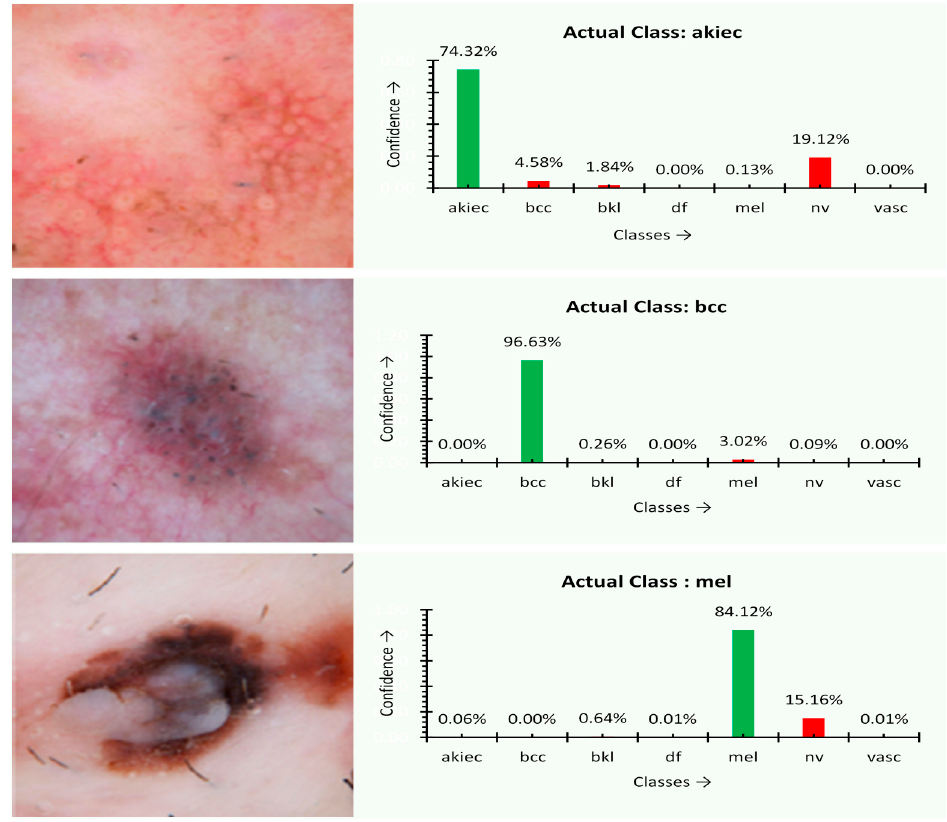
Figure 5. Classification confidence and resultant output images with regular training.